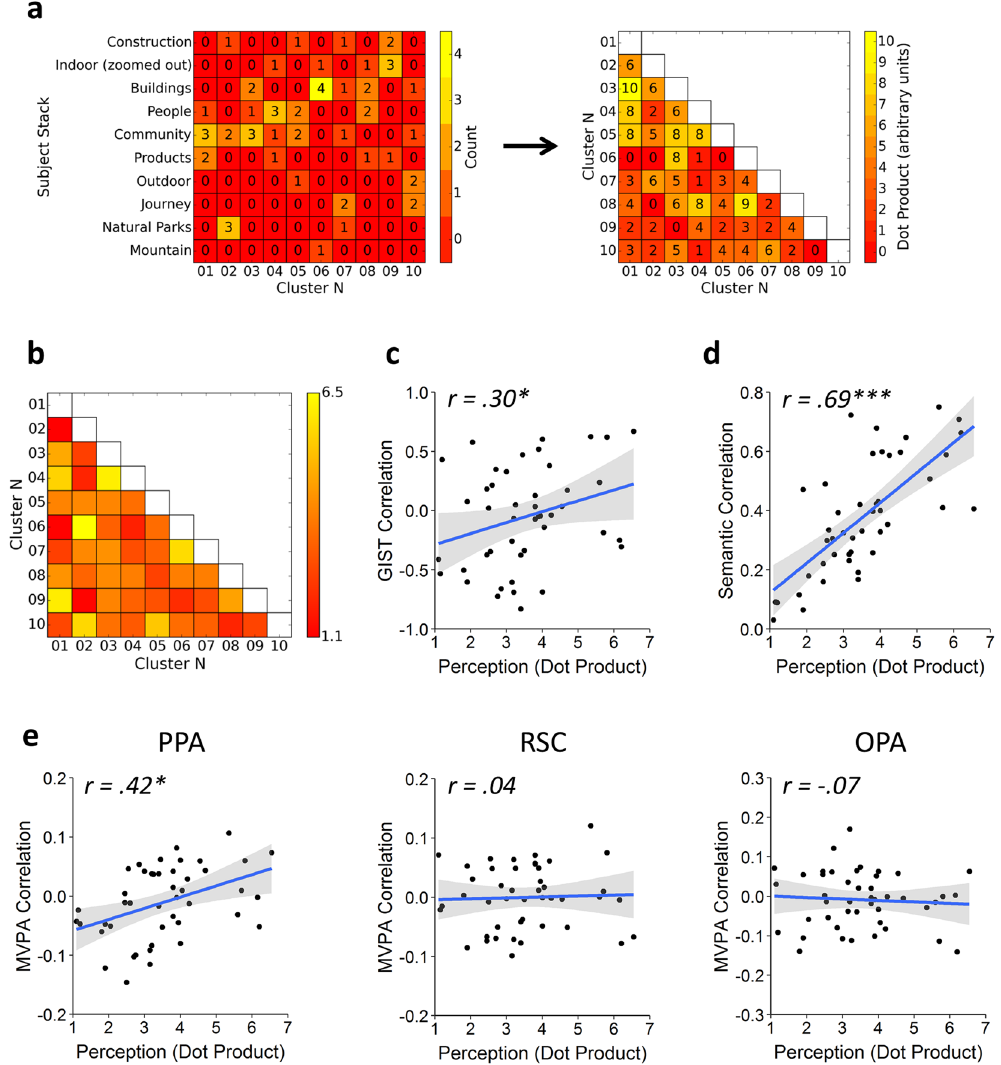
Figure 5. Behavioural experiment method and results. ( a ) Illustration of the analysis procedure for an example subject. A matrix of counts (left) was generated for each of the scene clusters (columns) against each of the subject’s card stacks (rows). The card stack labels were generated by the subject themselves. The lower triangle of a “perceptual” similarity matrix (right) was then constructed by calculating the dot-product between each pairwise combination of columns in the counts matrix. The group average dot product similarity matrix ( b ) was then compared against the off-diagonal elements of the: ( c ) GIST model, ( d ) local semantic concept model, and ( e ) MVPA similarity matrices in a series of representational similarity analyses. Shaded regions on scatterplots indicate 95% confidence intervals. ( *** p < 0.001, ** p < 0.01, * p <